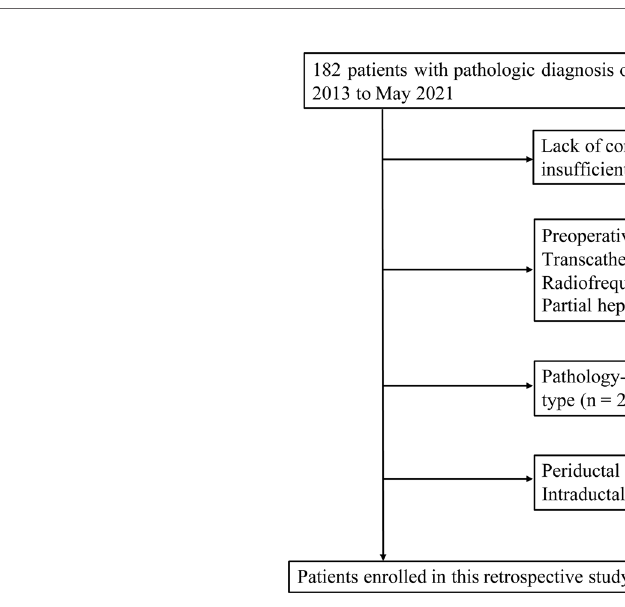
FIGURE 1 | Flow chart of patients recruitment in this